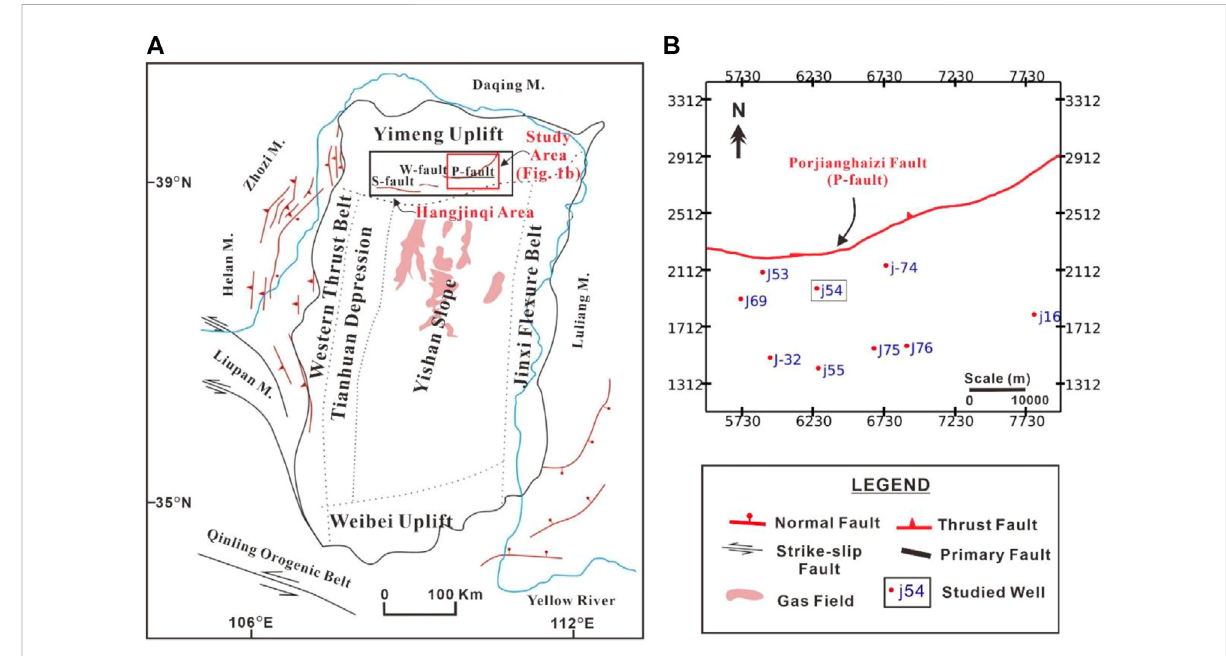
FIGURE 1 (A) The Ordos Basin ’ s primary tectonic units. The red colored text and box show the Hangjinqi study area. (B) 3D seismic grid along with wells utilized to execute the research. The P-fault is the main fault within the Hangjinqi